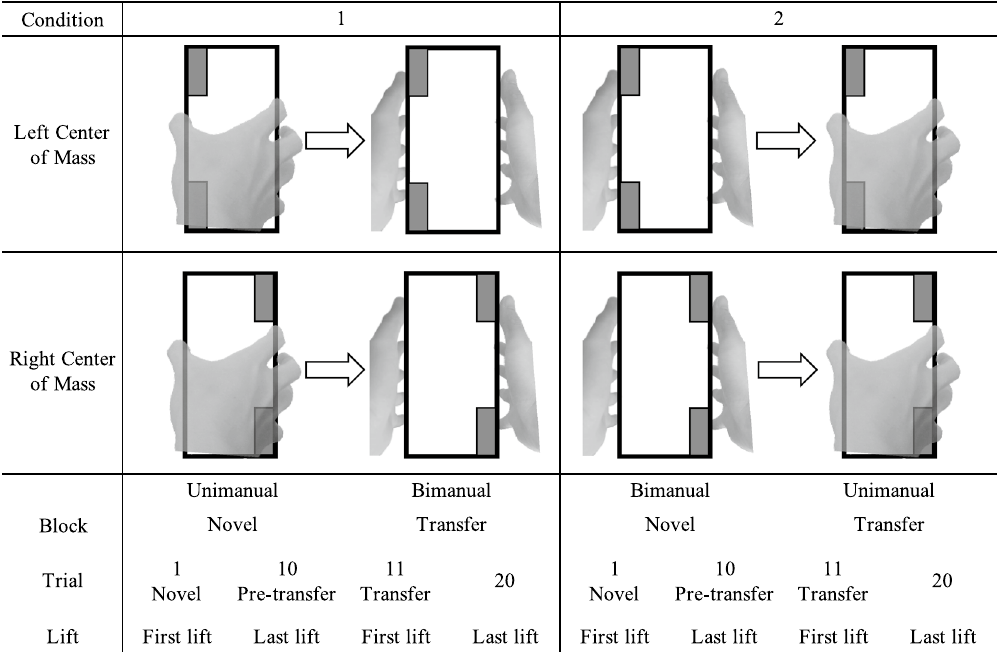
Table 1. Grasp order of each condition. Breakdown of the direction of transfer and direction of torque used for each condition. 10 participants performed lifts in condition 1 and another 10 participants performed lifts in condition 2. Center of mass order was counterbalanced. Trial 1 for both conditions represents participants’ first lift with the object. Trial 11 represents the first post-transfer lift. Trials 10, and 20 represent the last lift in either grasp